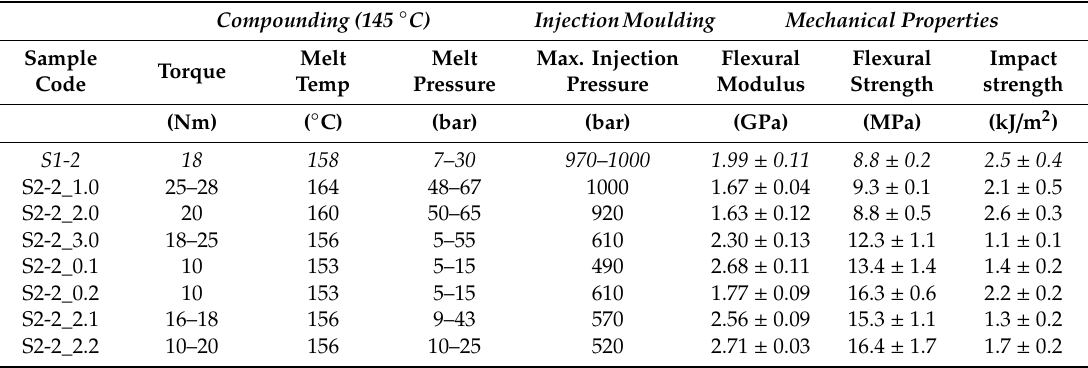
Table 4. Recorded processing parameters for the compounds, and mechanical properties of the green bodies of Series 2. The properties of the basic formulation S1-2 are listed as a